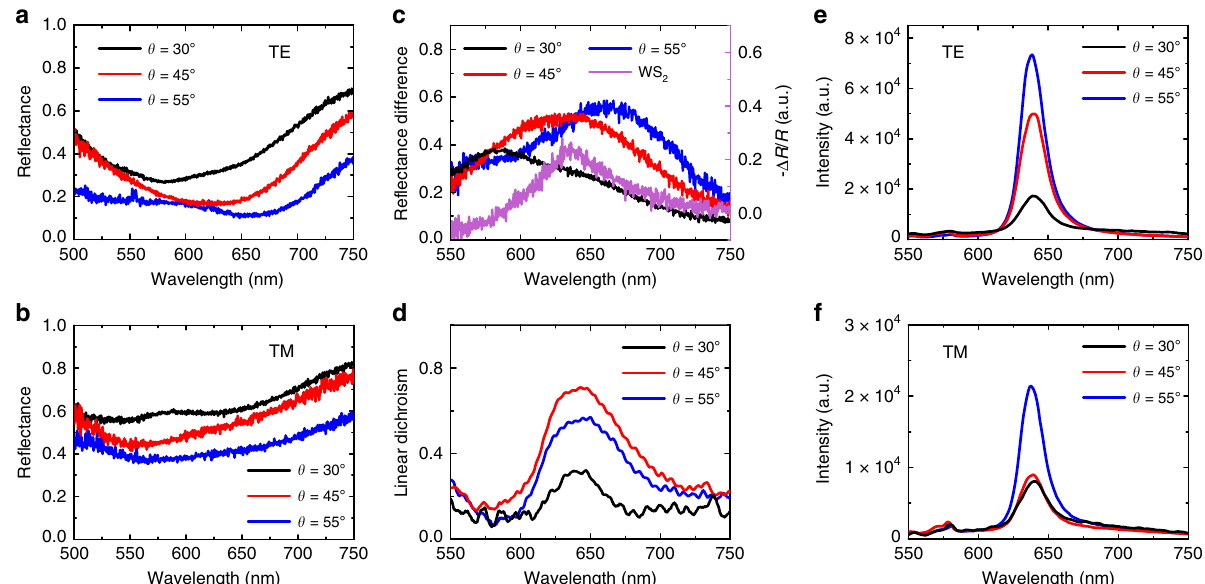
Fig. 5 Plasmon and exciton coupling in three types of WS 2 -Ag hybrid nanostructures. Re fl ectance spectra are measured for the TE polarized light incidence in ( a ) and TM polarized in ( b ) for varying slanting angles. c Re fl ectance difference between TE and TM polarizations. The differential re fl ectivity of the WS 2 monolayer is depicted by the purple curve. d Measured linear dichroism of the PL emission. e , f Intensity comparison among the three hybrid nanostructures for TE and TM polarized PL emissions,